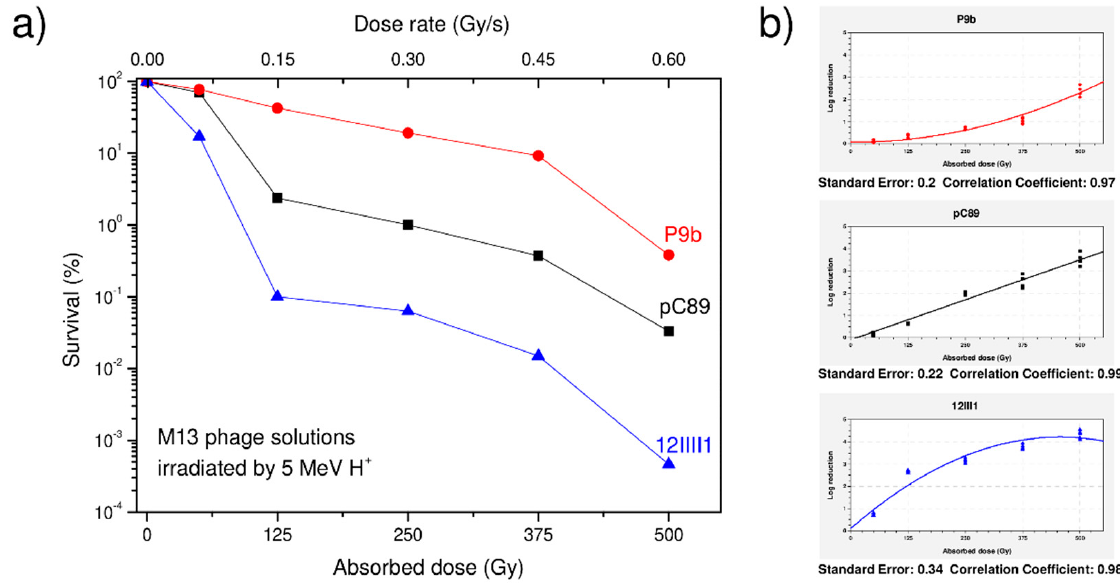
Figure 3. Susceptibility trend of pC89, 12III1 and P9b to proton beam radiation in terms of survival percentage ( a ) and logarithmic viability reduction ( b ).